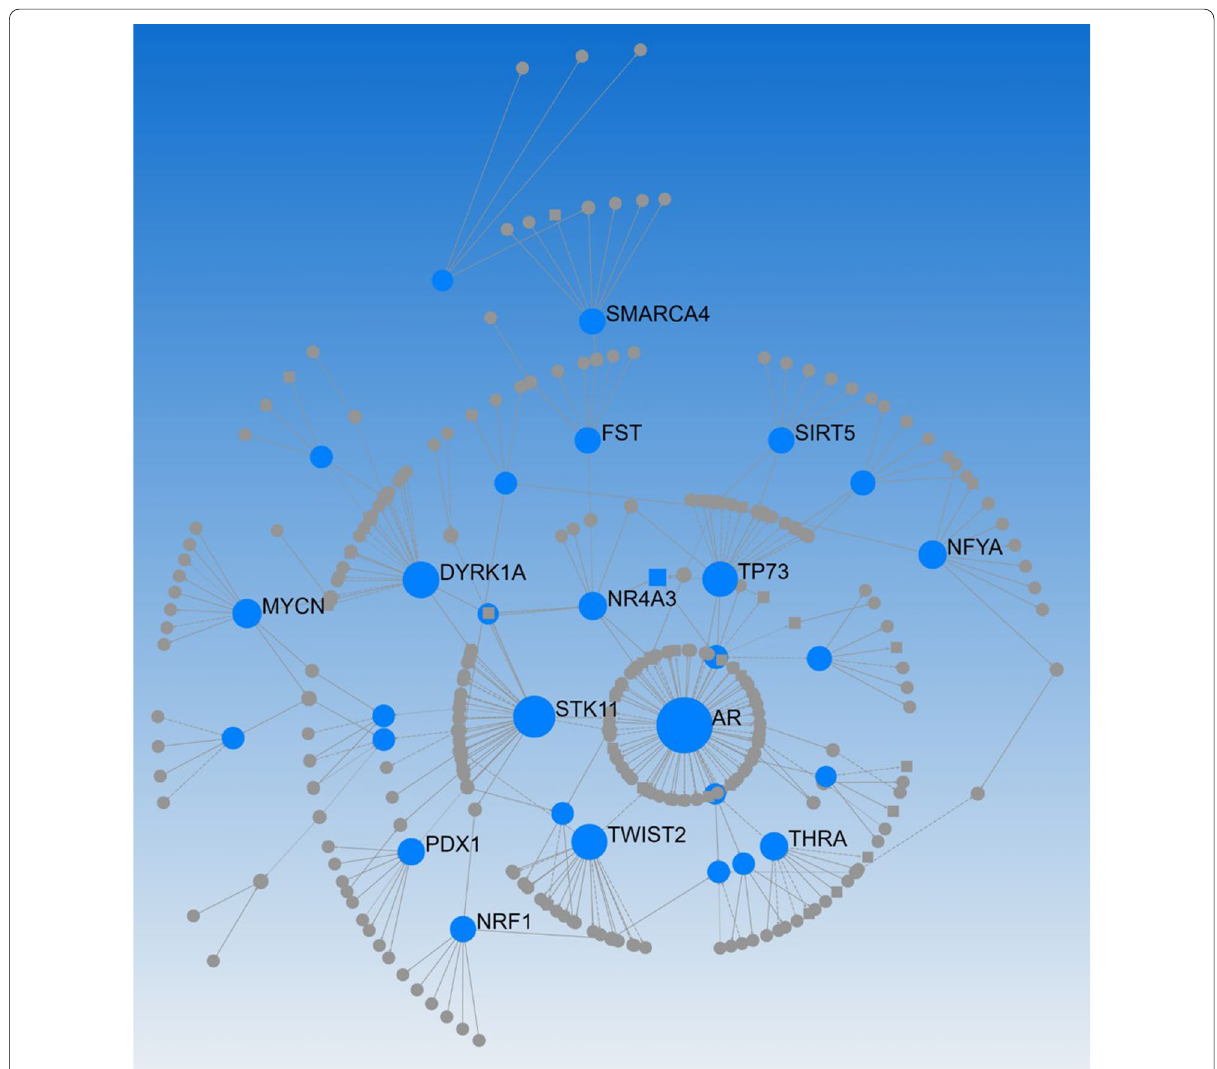
Fig. 6 The backbone network’s topology constructed based on 11 nodes with a high BC value, where sizes of nodes are proportional to their BC